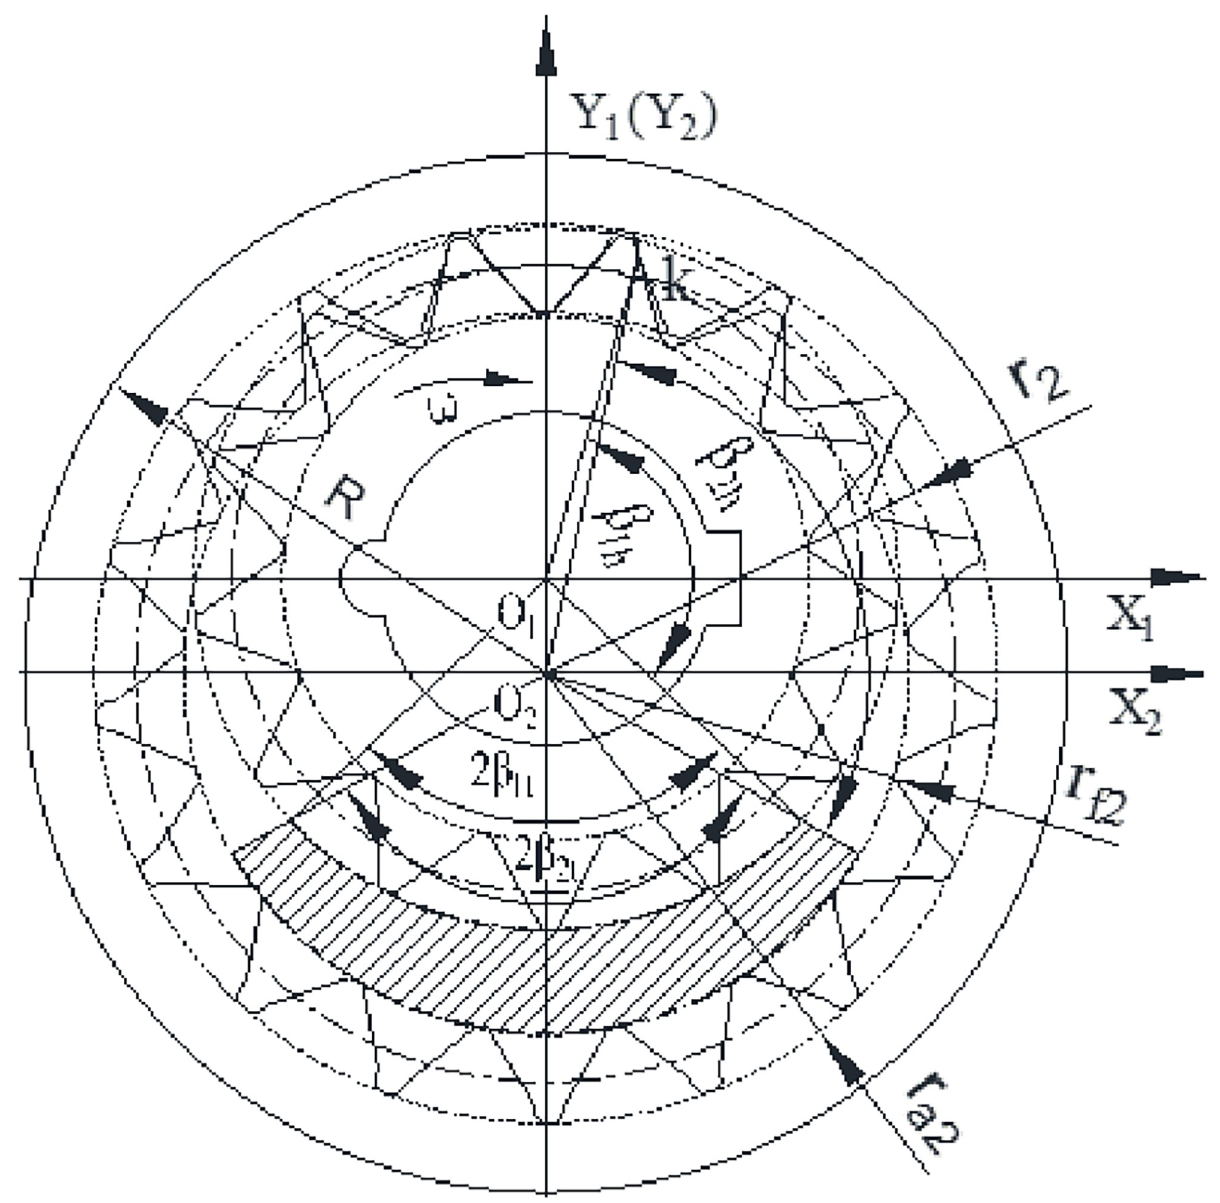
Fig 5. Schematic diagram of regional division on the gear end